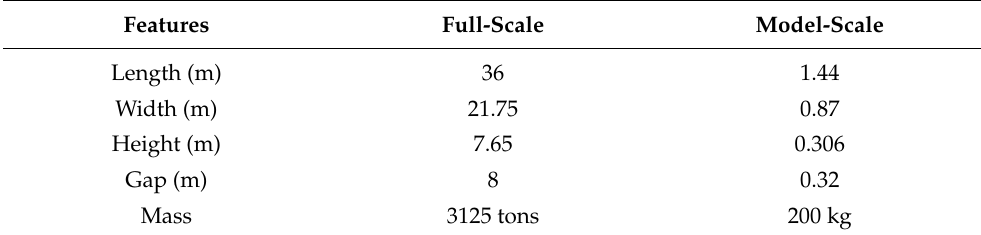
Table 1. Raft description. The gap is the space between the